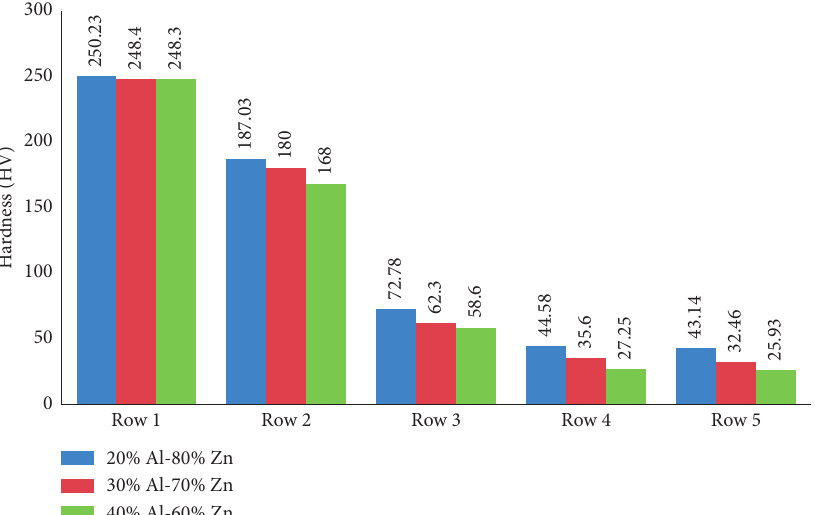
Figure 7: Hardness of the three coatings.